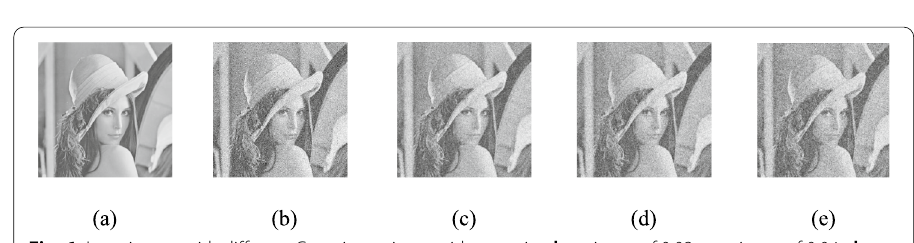
Fig. 6 Lena image with different Gaussian noise: a without noise, b variance of 0.03, c variance of 0.04, d variance of 0.06, e variance of